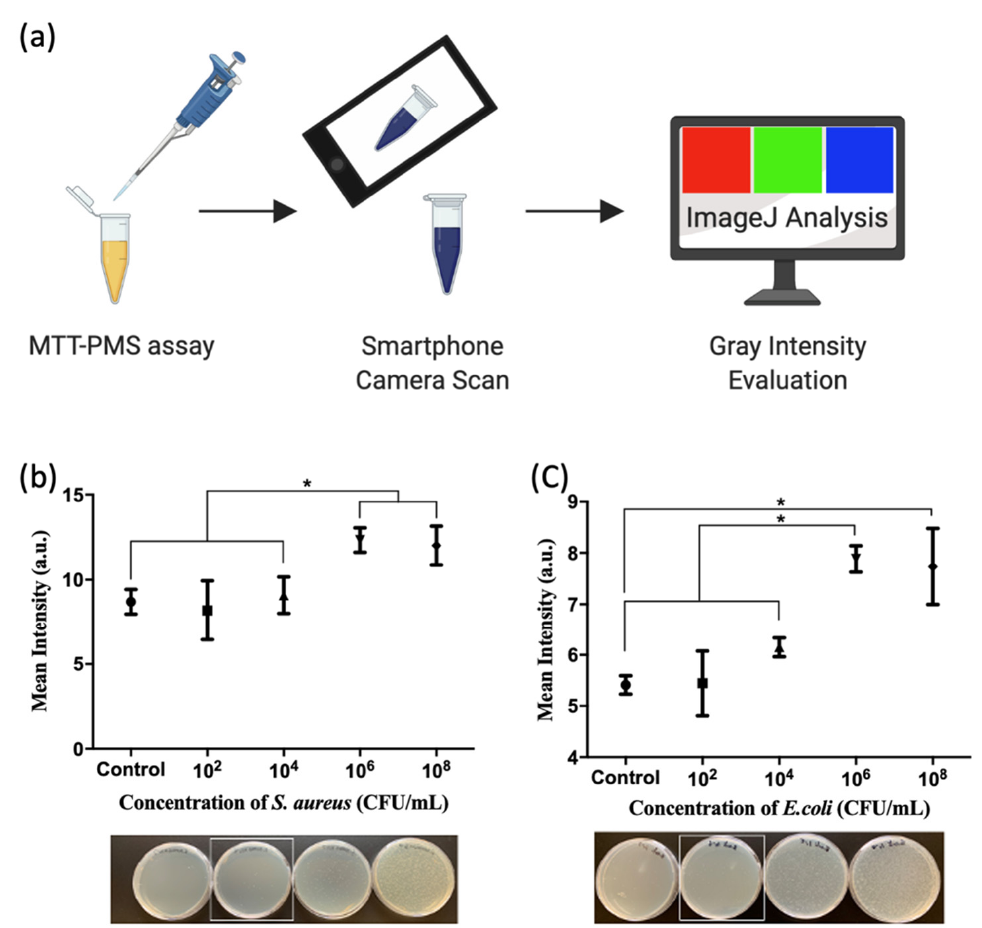
Figure 5. Integration of the 3-(4,5-dimethylthiazol-2-yl)-2,5-diphenyltetrazolium bromide-phenazine methosulfate (MTT-PMS) assay with a smartphone camera: ( a ) After adding MTT-PMS to the experimental tube, results were scanned with a smartphone (iPhone XS, Apple). The gray intensity was evaluated using a freeware App “ImageJ”[31]; Results of the MTT-PMS assay for ( b ) S. aureus and ( c ) E. coli . Figure created in BioRender.com. * p < 0.05.